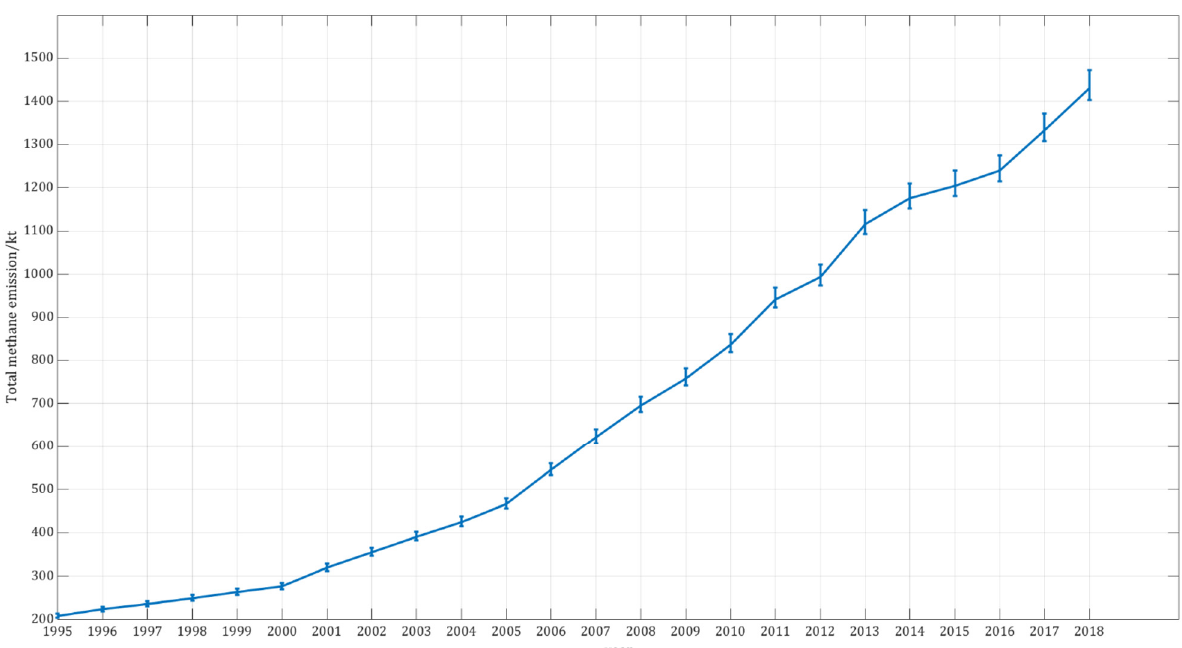
Figure 2. Total methane emission and uncertainty from China’s oil and natural gas sector, 1995– 2018.